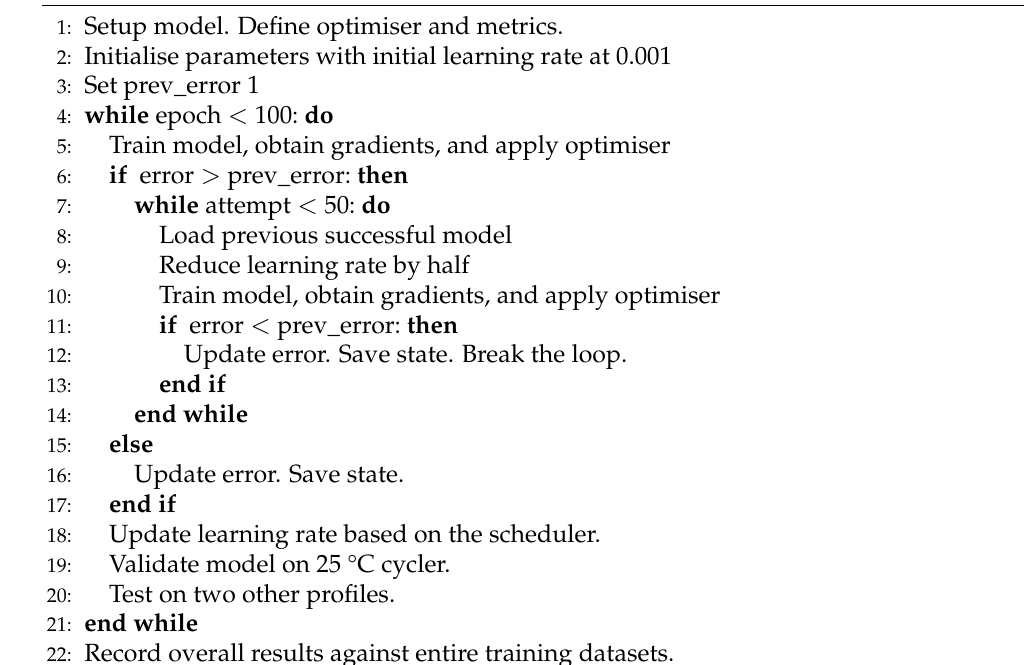
Algorithm 7 Training